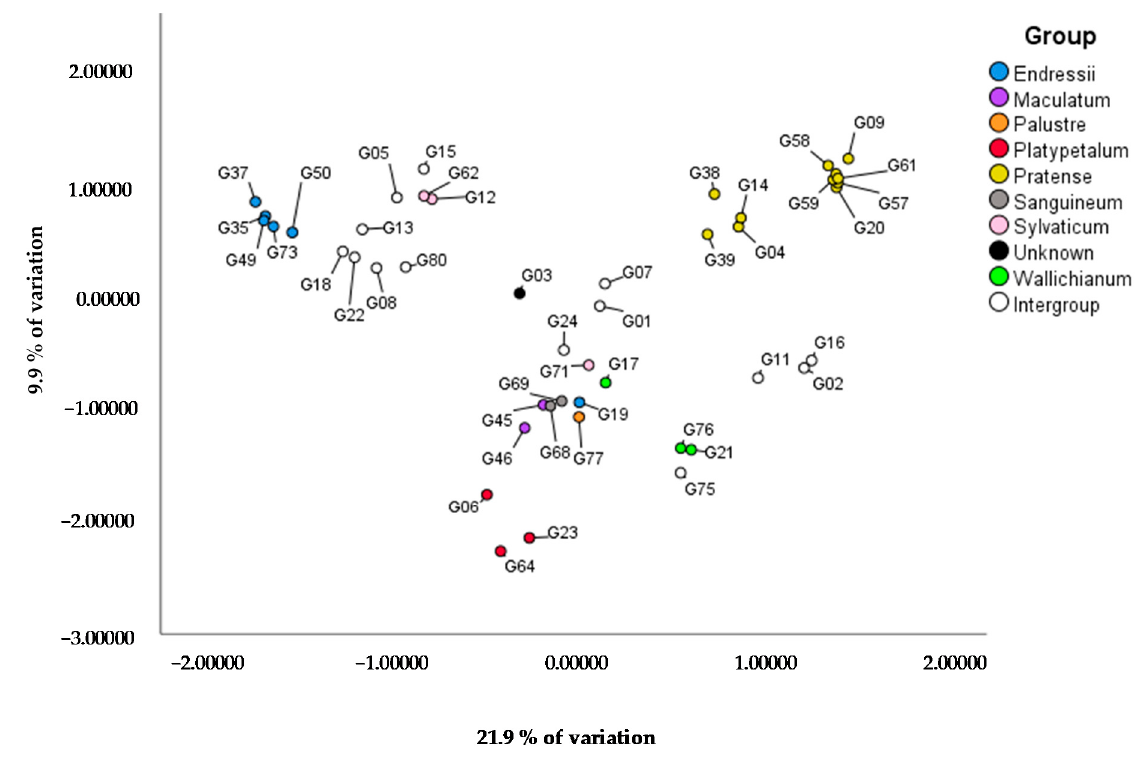
Figure 2. PCoA based on AFLP data of genotypes of subgenus Geranium (in total 45 plants) with X and Y-axis explaining 21.9% and 9.9% of the variation, respectively.